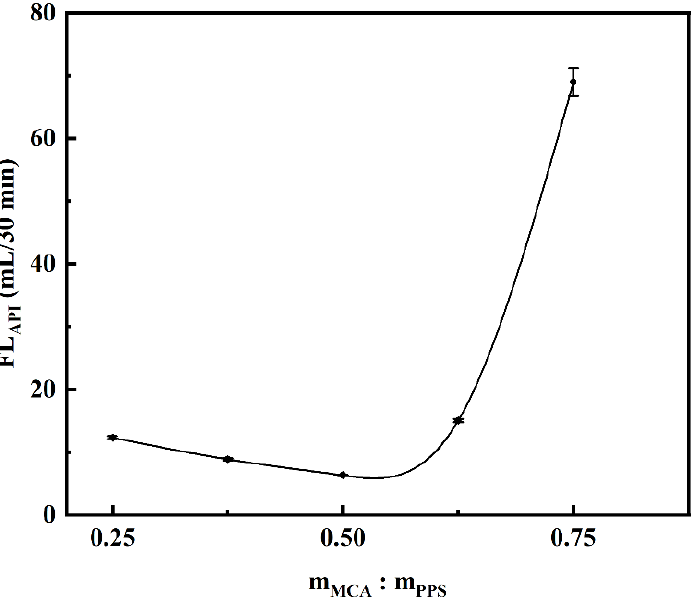
Figure 7. Effect of MCA on saturated NaCl brine base slurry filtration loss performance of CMCS. (The mass ratio of m NaOH : m PPS was 0.50 and the etherification temperature was 75 °C).